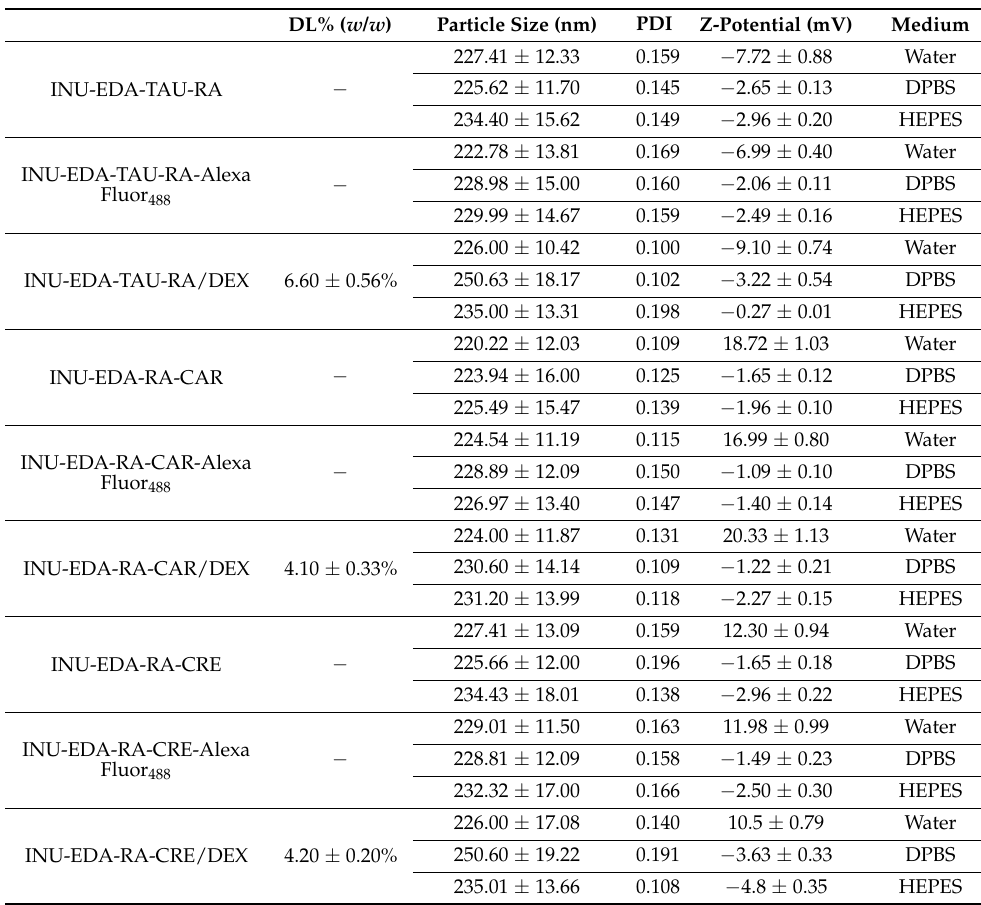
Table 3. Particle size (nm), PDI, Z-potential (mV) e Drug loading % ( w / w ) ± standard error evaluated for all the prepared